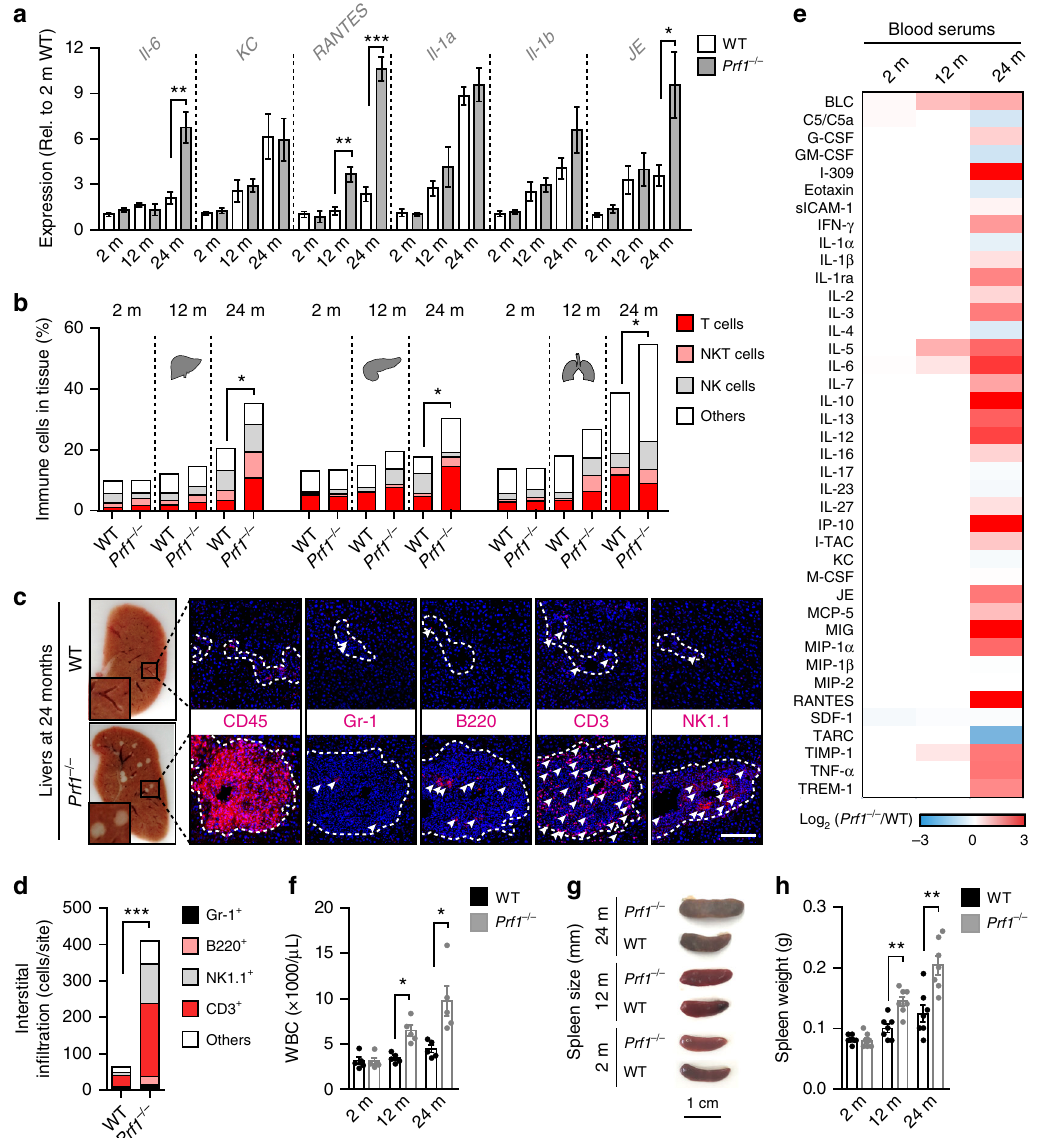
Fig. 2 Prf1 − / − mice develop chronic systemic and local in fl ammation. a Real-time qPCR analysis for expression of p16 and SASP components in livers from 2, 12, and 24-months-old Prf1 − / − and WT female mice. ( n = 5 mice per group). b Flow-cytometric quanti fi cation of total immune cells (CD45 + ), T cells (CD45 + /CD3 + /NK1.1 − ), NKT cells (CD45 + /CD3 + /NK1.1 + ), and NK cells (CD45 + /CD3 - /NK1.1 + ) in livers, pancreas, and lungs of 2, 12, and 24-months- old Prf1 − / − and WT mice. ( n ≥ 5 mice per group). c Immune foci observed (indicated in squares, left panel) in liver cryosections from old Prf1 − / − and WT mice. The immune foci were analyzed on sections stained immuno fl uorescently for CD45, Gr-1, B220, CD3, and NK1.1. Scale bar, 100 µ m. d Numbers of the different immune subsets in livers from old Prf1 − / − mice and WT mice, based on the immuno fl uorescence staining presented in ( c ). e Array of serum cytokine levels in 2, 12, and 24-months-old Prf1 − / − female mice relative to WT female mice at the corresponding age. Colors represent increase (red) or decrease (blue) in the average intensity of 3 pooled samples. Values are shown in log2 according to the legend panel. f White blood cell counts of 2, 12, and 24-months-old Prf1 − / − and WT female mice. ( n = 5 mice per group). g Representative photos of spleens from 2, 12, and 24-months-old Prf1 − / − and WT female mice. h Spleen weights of 2, 12, and 24-months-old Prf1 − / − and WT female mice. ( n = 7 mice per group). For all graphs, values are means ± SEM. Student ’ s t -test was used for all comparisons between Prf1 − / − and WT mice. (* P < 0.05, ** P < 0.01, *** P < 0.001) example, old mice, like old humans, tend to be less active than also suffered from progressive weight loss (Fig. 3l), which was young ones. To evaluate the overall fi tness of Prf1 − / − mice we comprised of both muscle loss and fat loss (Supplementary tested their voluntary exercise, as well as their muscle strength Figure 5b). Another aspect of organism-level fi tness reduction is and coordination. We found that old Prf1 − / − mice showed a kyphosis, an exaggerated rounding of the spine. Old Prf1 − / − mice reduction of more than 2-fold in voluntary exercise ( P < 0.05; exhibited a higher incidence of age-related kyphosis than old WT Fig. 3j, Supplementary Figure 5a), and their grip strength and mice ( P < 0.05; Fig. 3m). An age-related pathology reported to be coordination in a “ hang-wire ” test were signi fi cantly decreased, common in C57BL/6 males is enlargement of the seminal compared to old WT mice ( P = 0.044; Fig. 3k). Mammals also glands 39,40 . Interestingly, many of the old Prf1 − / − males in our tend to lose weight during late stages of life 39 . Old Prf1 − / − mice study had enlarged seminal glands (in 70% of Prf1 − / − mice NATURE COMMUNICATIONS| (2018) 9:5435